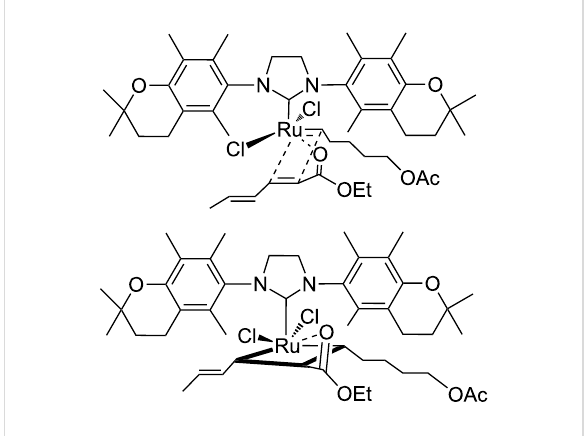
Figure 3: π -Complex and rutenacyclobutane intermediate with a five- membered ring chelate.